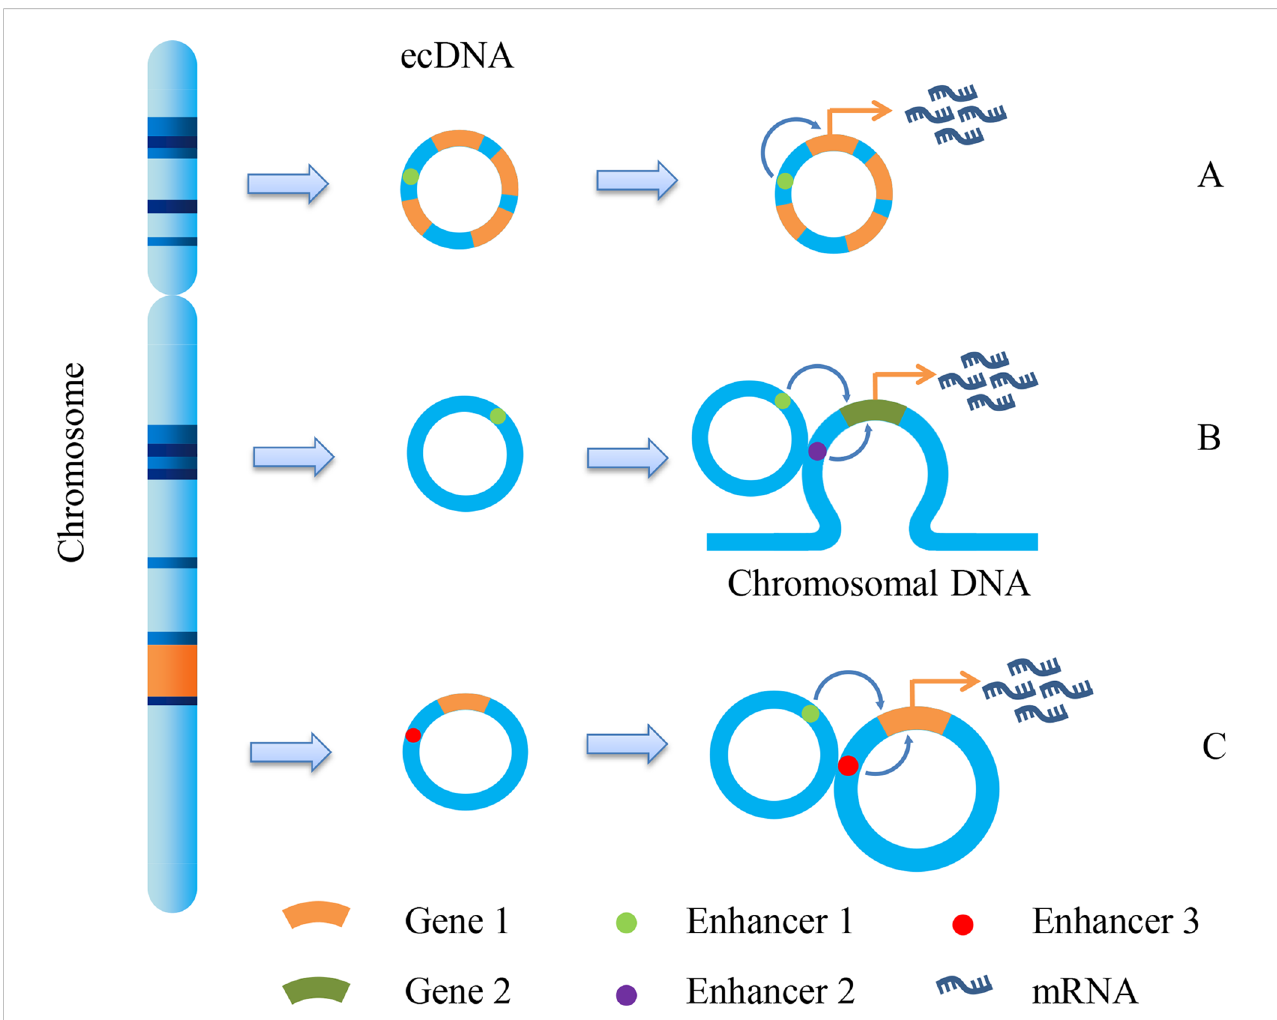
FIGURE 2 ecDNA promotes gene transcription. Due to the different fragments carried by ecDNA, it promotes gene transcription and expression in different ways. There are mainly three methods shown in the fi gure: (A) Enhancer1, located on ecDNA, can promote the expression of gene 1; (B) Enhancer1, located on ecDNA, can promote the expression of gene 2 on chromosomes; (C) the enhancer 1 on the ecDNA can promote the expression of gene 1 on another ecDNA, and the enhancer 3 on this ecDNA can also promote the expression of gene